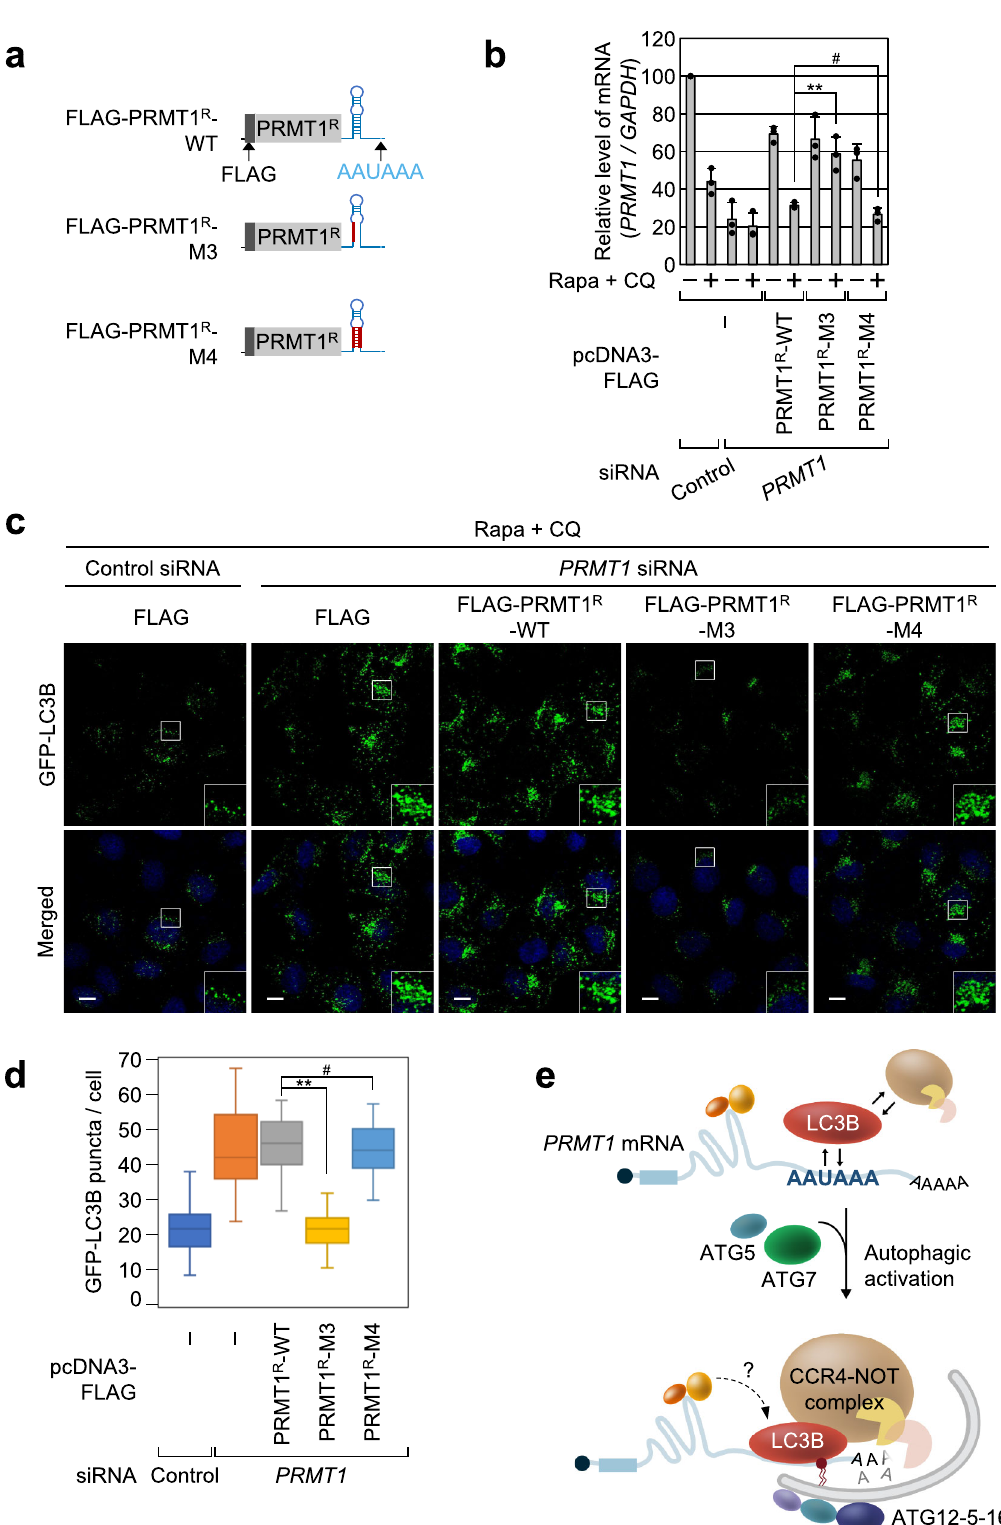
fl uoride (Sigma-Aldrich), and 0.25 mM sodium orthovanadate (Sigma-Aldrich)]. The cell extracts were sonicated and precleared with protein G agarose 4B beads (Incospharm) for 1 h at 4°C. Next, the samples were incubated with either antibody-conjugated beads or FLAG M2 af fi nity gel (Sigma-Aldrich) at 4°C. After 3h, the beads were washed four times with NET-2 buffer and eluted with 2× sample buffer. The samples were analyzed using western blotting.